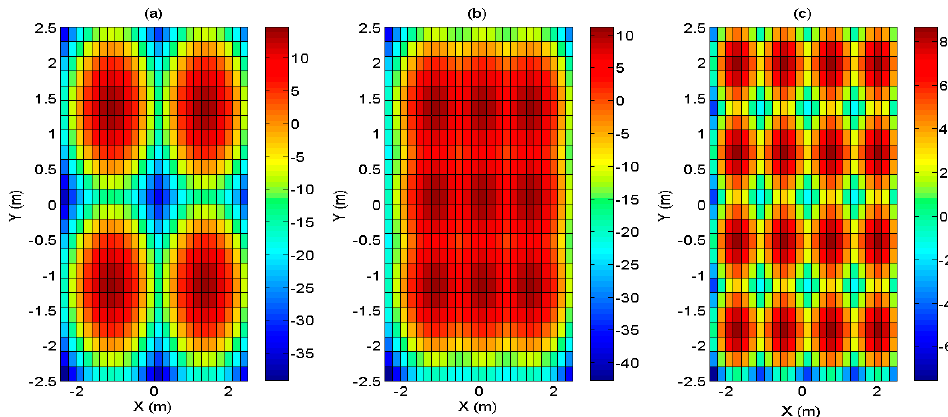
Figure 4. Received power (dBm) at ∅ 𝟏/𝟐 =10° ( a ) the case of 4 arrays, ( b ) the case of 9 arrays, and ( c ) the case of 16 arrays. Table 4. Power received at ∅ 1/2 = 10 ◦ . P r (dBm)